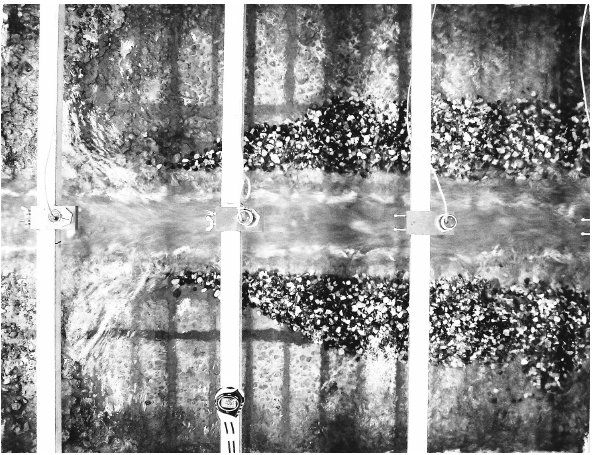
Figure 12. Evolution of the outflowing bed load intensity (cid:56) o for the sediment flushing attempts after the α and β hydrograph tests with non-overflowed hydraulic barrier (Hy-no), with indication of the relative discharge Q ∗ and bed load supply intensity (cid:56) i , as a function of t ∗